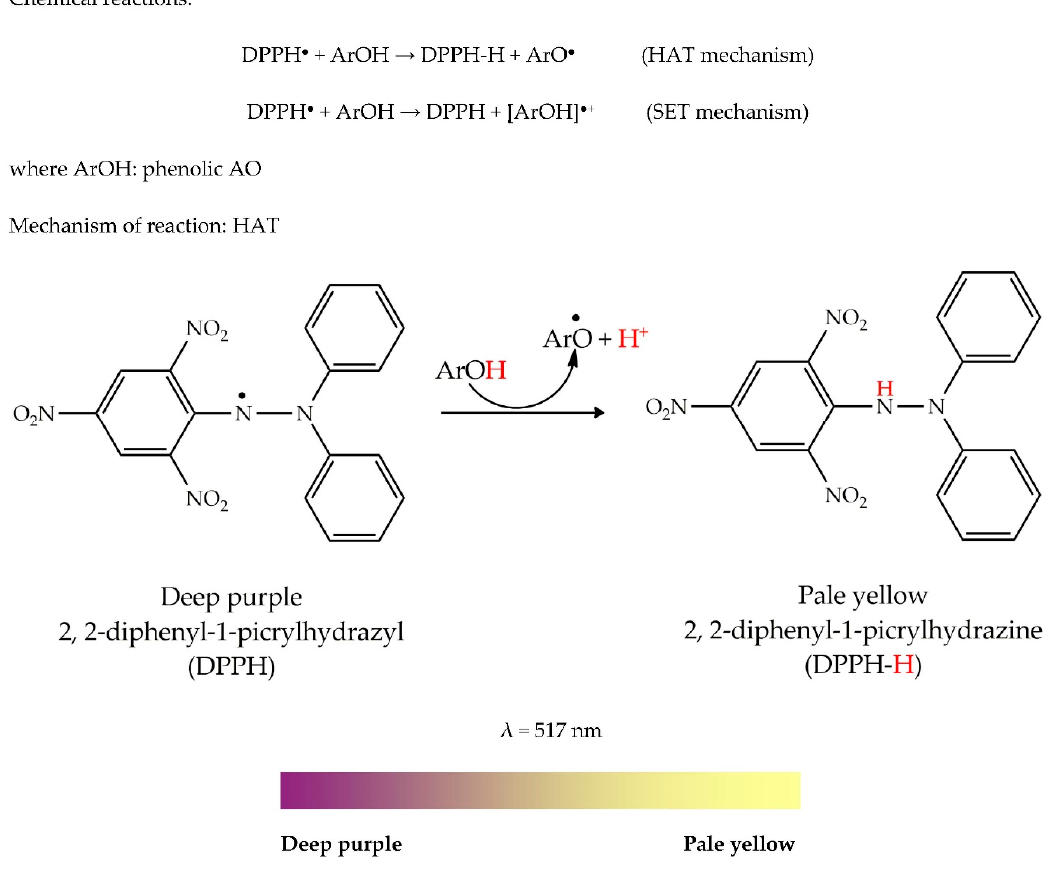
Figure 3. 2, 2-diphenyl-1-picrylhydrazyl (DPPH) reaction mechanism. Figure 3. 2,2-diphenyl-1-picrylhydrazyl (DPPH) reaction